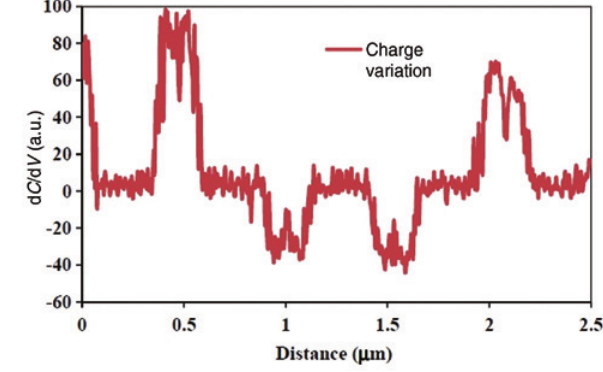
Figure 16: SCM cross-section analysis of Figure 15B for the 2.5 μ m distance. The positive peaks represent FGs with stored charges, while the negative peaks represent FGs